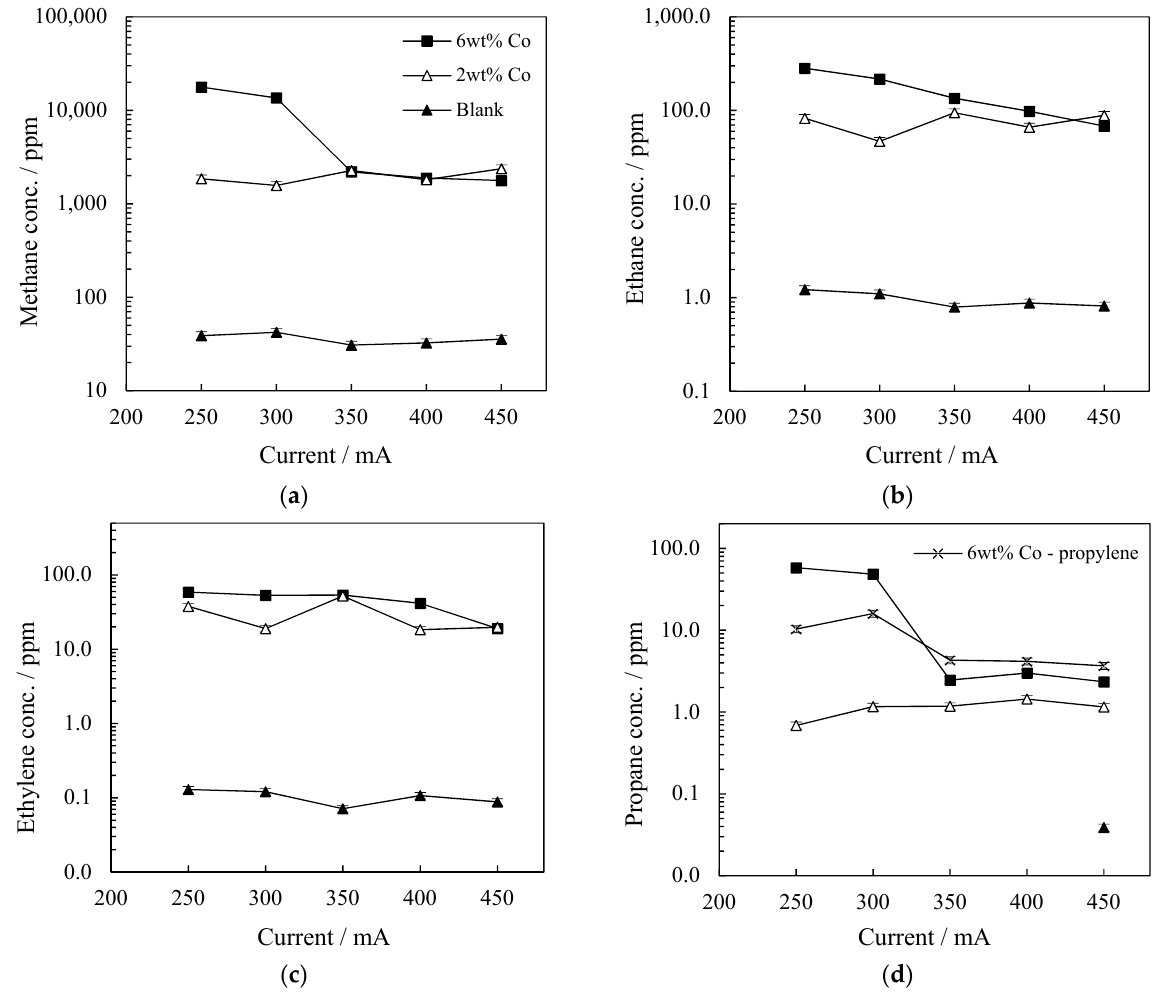
Figure 7. The influence of current on hydrocarbon concentration for plasma-catalytic FTS (NTP + Blank, 2 or 6 wt% Co catalyst) at a discharge time of 60 s; ( a ) methane, ( b ) ethane, ( c ) ethylene and ( d ) propane/propylene. Legend: ■ —6 wt% Co; Δ —2 wt% Co; ▲ —Blank; Χ —6 wt% Co (propylene). Operating conditions: Syngas (H 2 /CO) ratio: 2.2:1; pressure: 2 MPa; inter-electrode gap: 1 mm; wall temperature: 25 °C. Error bars (vertical): Expanded experimental hydrocarbon concentration uncertainty of ±11%.